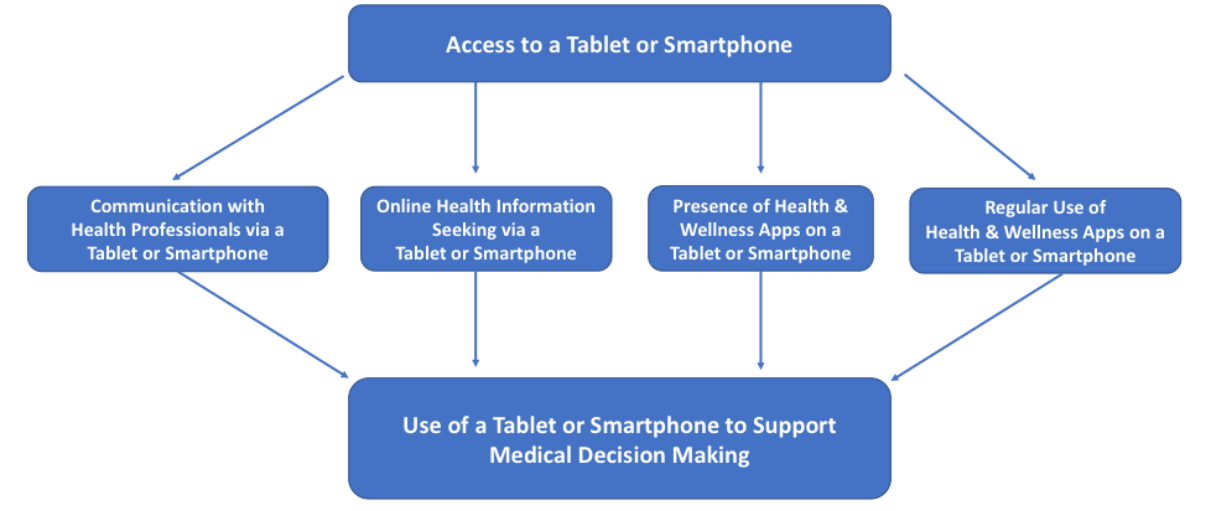
Figure 1. Conceptualization of How Mobile Devices May Help Support Medical Decision